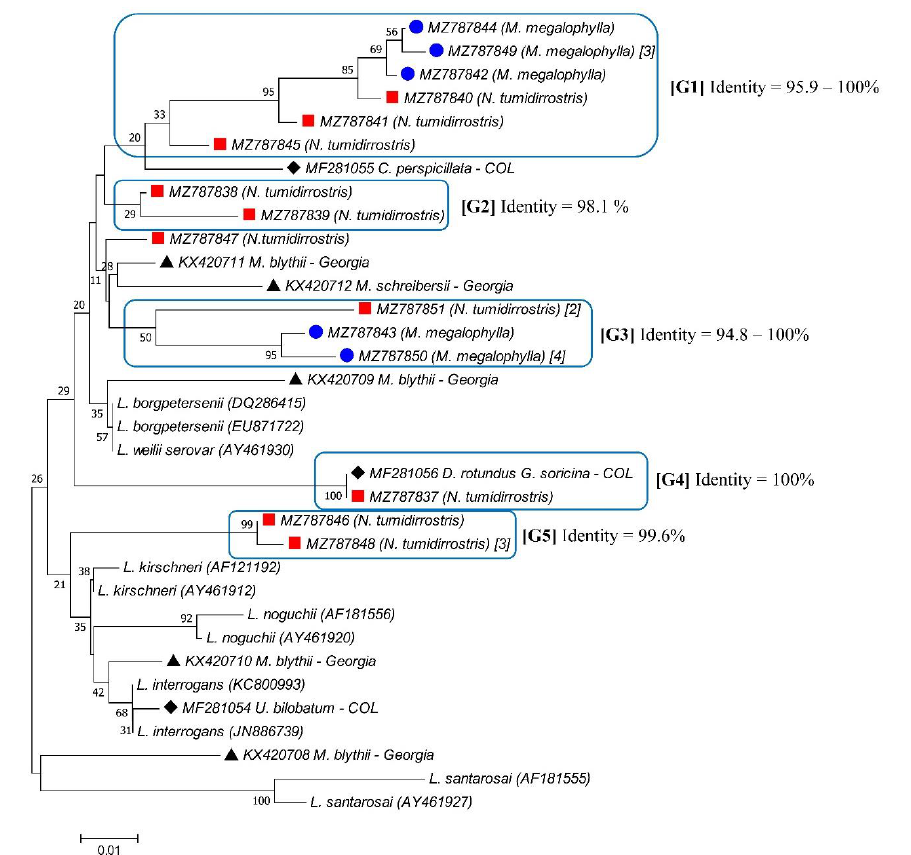
Figure 2. LipL32 gene sequence-based phylogenetic tree for Leptospira spp. detected in bats. The sequences retrieved in this study are indicated by symbols: blue circles from M. megalophylla and red squares from N. tumidirostris ; numbers in brackets in MZ787849, MZ787850, MZ787851, and MZ787848 sequences represent the number of sequences obtained from bat specimens; sequences without a particular number in brackets depict that only a sequence was obtained. GenBank numbers from reference sequences are indicated in brackets, and Leptospira spp. sequences obtained from bat species from previous studies are indicated by black rhombuses and black triangles [21,31]. Leptospira groups and identity percentages between sequences for each group are illustrated.